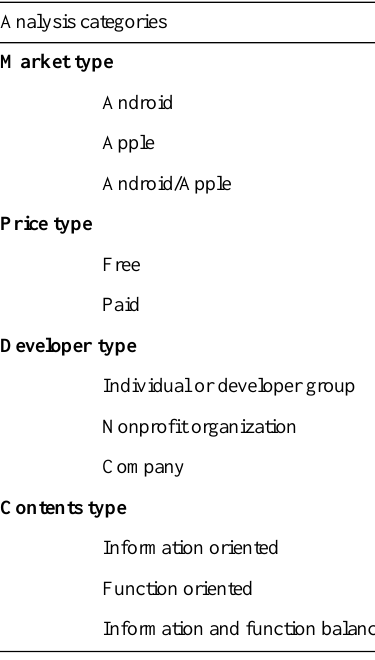
Table 1. Descriptive statistics of smoking cessation apps in the sample